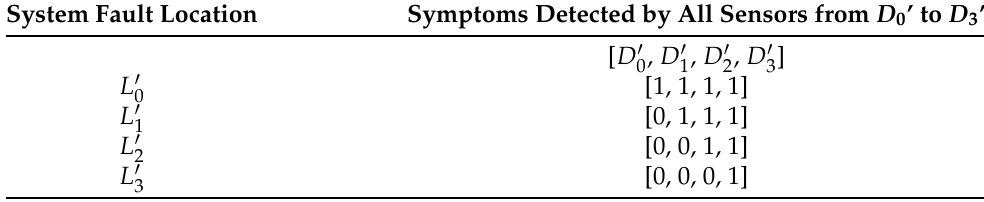
Table 4. The updated fault-symptom table of the new four-layer system.